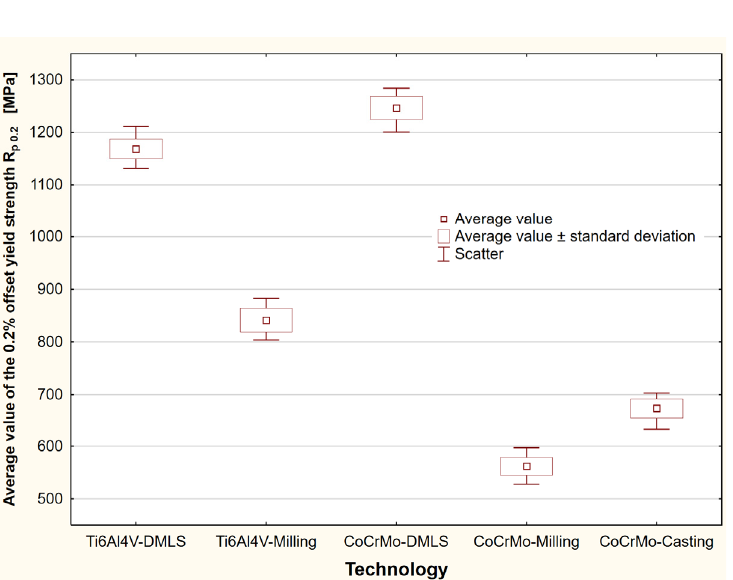
Figure 7. Statistical study to determine the offset yield strength under compression, depending on the manufacturing technology.